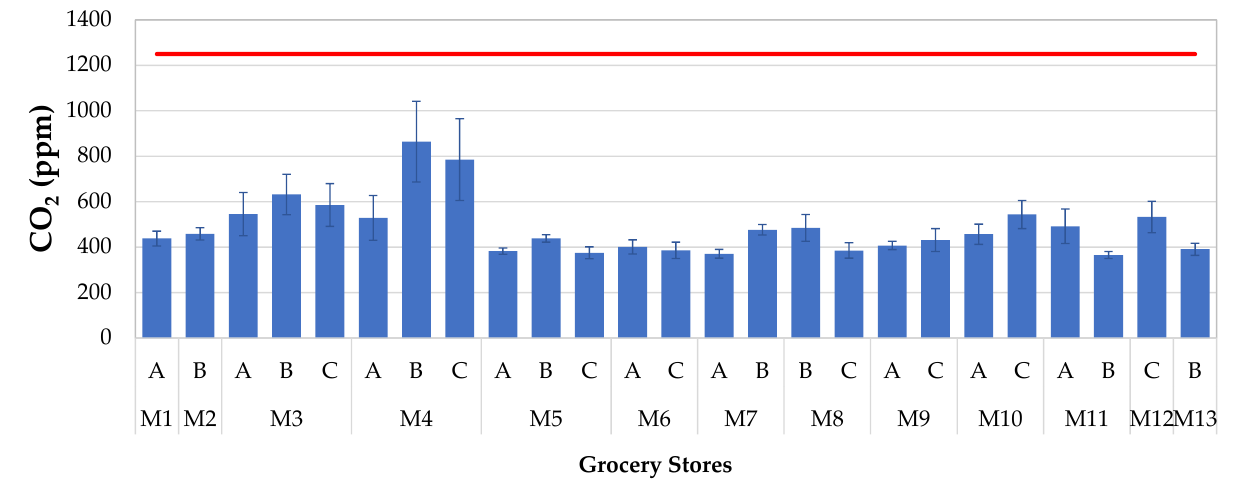
Figure 4. CO 2 levels assessed in all locations of the studied GSs. The red line represents the limit value of 1250 ppm established by Portuguese legislation [34].